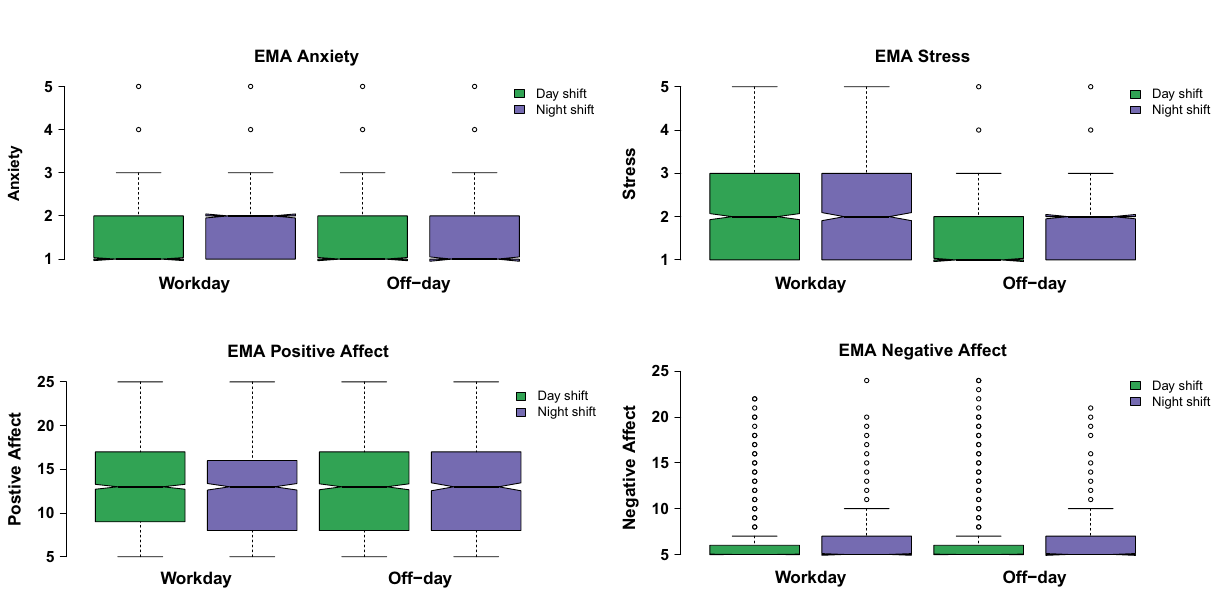
Figure 1. Distribution of EMA responses (affect, anxiety and stress) compared with shift and work